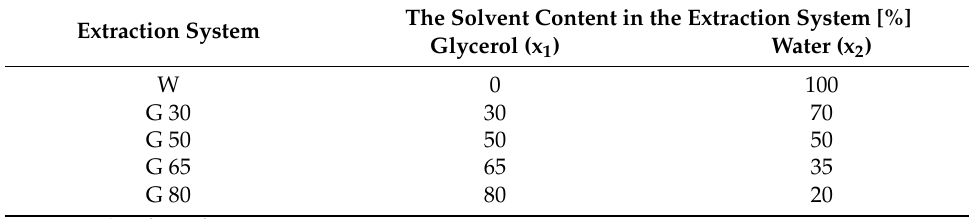
Table 1. Solvent content of the extraction systems used in the experiment. Extraction